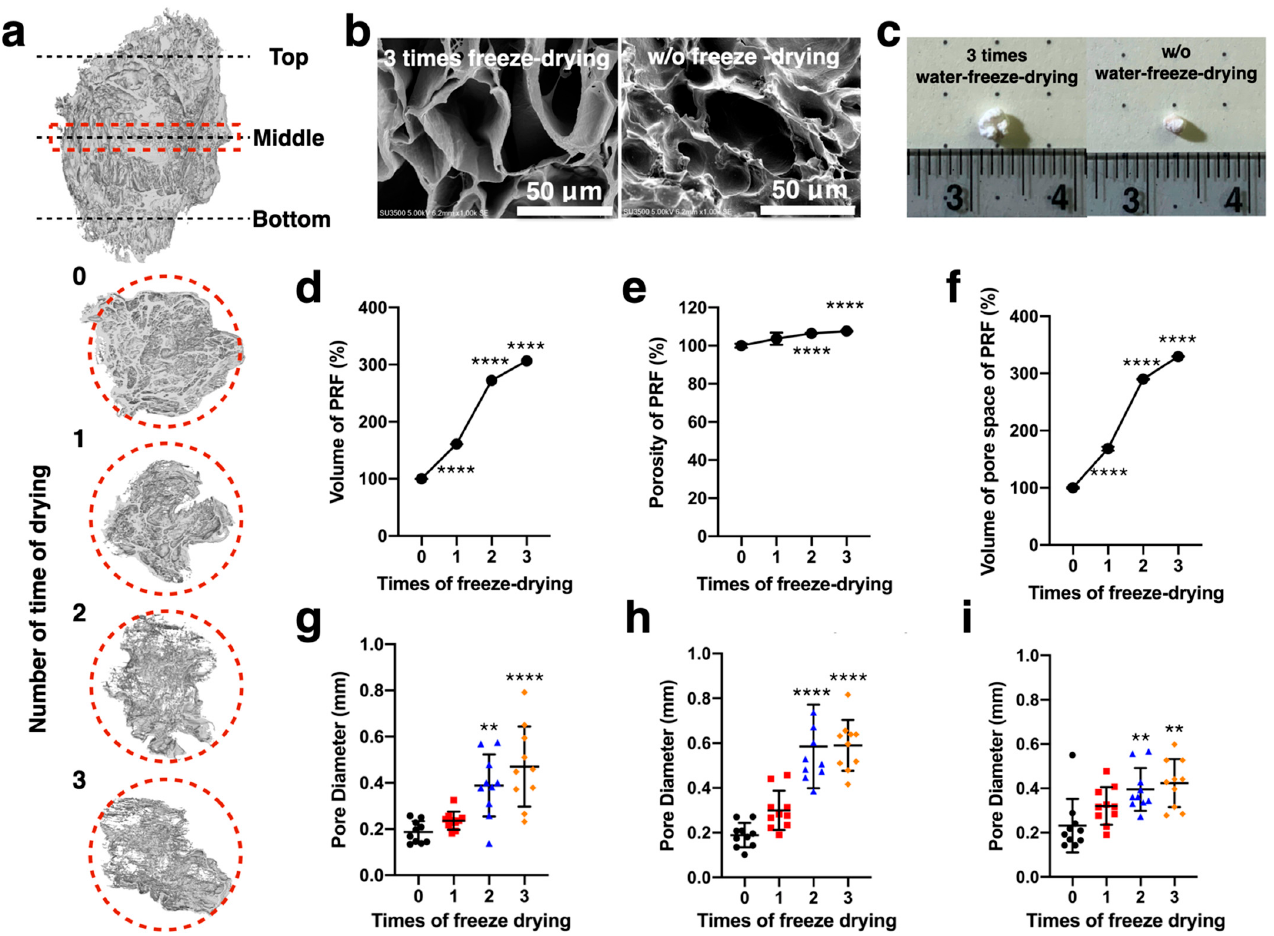
Figure 2. Platelet-rich fibrin scaffold preparation and analysis. After collection, the platelet-rich fibrin was subjected to repeated freeze drying to remove the water naturally present within it. It was then immersed in water and dried using three cycles of the repeated freeze drying method to expand the pores, thus enabling cell migration and ingrowth. Large-pore platelet-rich fibrin was thereby produced. ( a ) Micro-CT images of platelet-rich fibrin after several iterations of freeze drying; ( b ) scanning electron microscopy images of platelet-rich fibrin; ( c ) images of platelet-rich fibrin; ( d ) volume of platelet-rich fibrin; ( e ) porosity of platelet-rich fibrin; ( f ) volume of platelet-rich fibrin pores; ( g ) pore diameter of top-section platelet-rich fibrin; ( h ) pore diameter of middle-section platelet-rich fibrin; and ( i ) pore diameter of bottom-section platelet-rich fibrin. (Individual data points are shown as means ± SD; N = 5 per group; ** p < 0.01 and **** p <